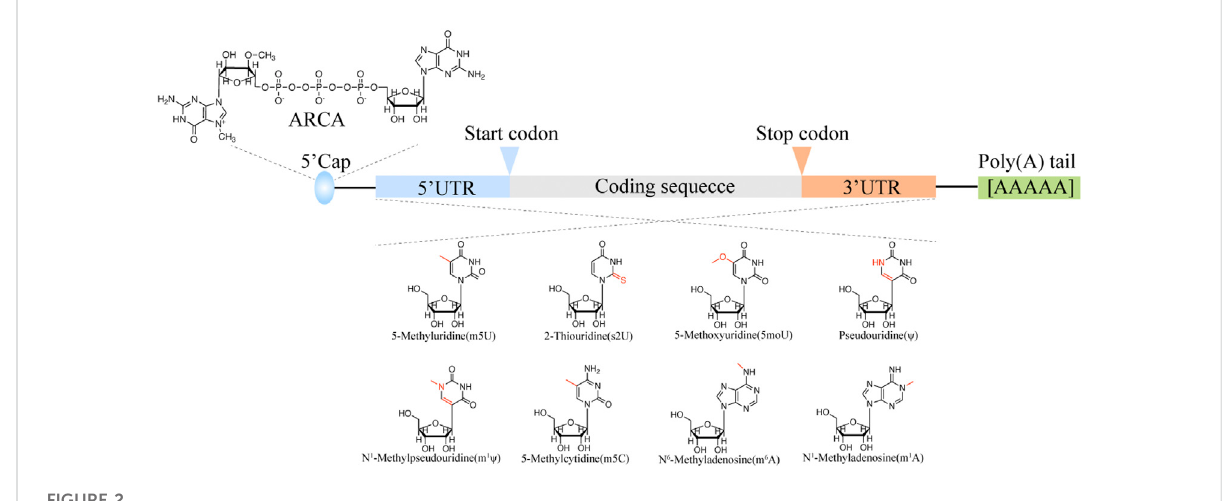
FIGURE 2 The optimization of IVT mRNA